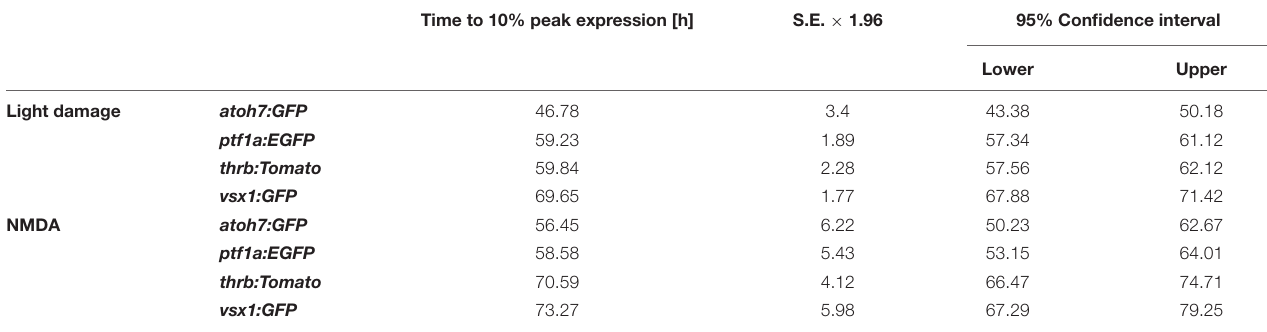
TABLE 5 | Time to 10% peak expression and the corresponding lower and upper limits of the 95% confidence intervals analyzed for the number of transgene-expressing PCNA-positive cells following light or NMDA